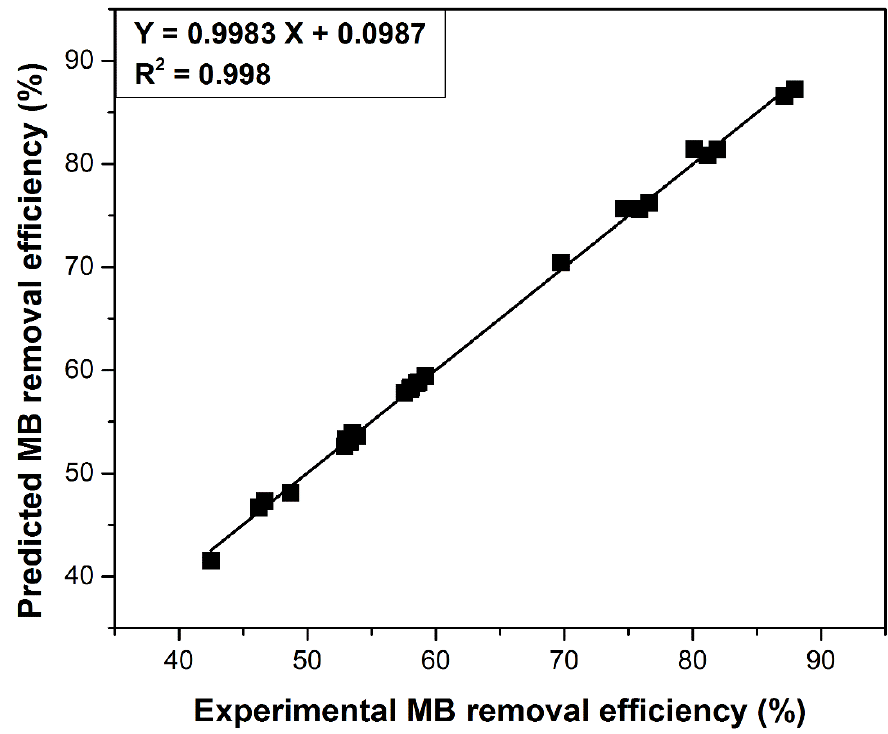
Figure 5. Comparison of experimental and predicted MB removal efficiency.